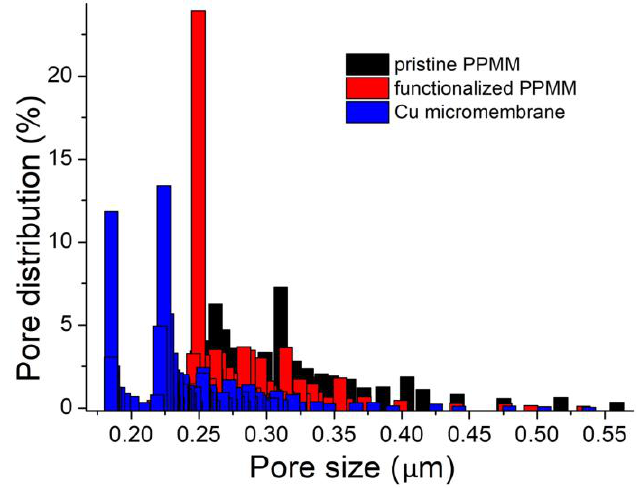
Figure 4. The pore size distribution for pristine PPMM, functionalized PPMM, and Cu micromembrane.